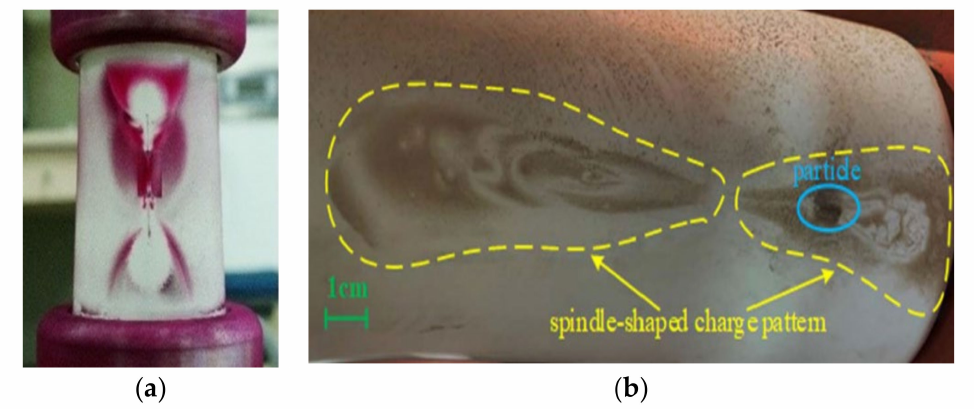
Figure 1. Measurement results obtained by Lichtenberg dust figure method. ( a ) Via toner dust [21], and ( b ) via silicate dust [22]. Table 1. Comparison of the Lichtenberg dust figure method and the Kelvin probe method. Methods Advantages Disadvantages Measurement result is not restricted by Cannot quantitatively characterize surface potential value and is not charge density (or electric field Lichtenberg dust figure influenced by charge decay process strength); dust adsorbed may have a during measurement. certain impact on local electric field. Surface potential value can be Low spatial resolution and relative low Kelvin probe quantitatively characterized with a voltage range; high sensitivity.